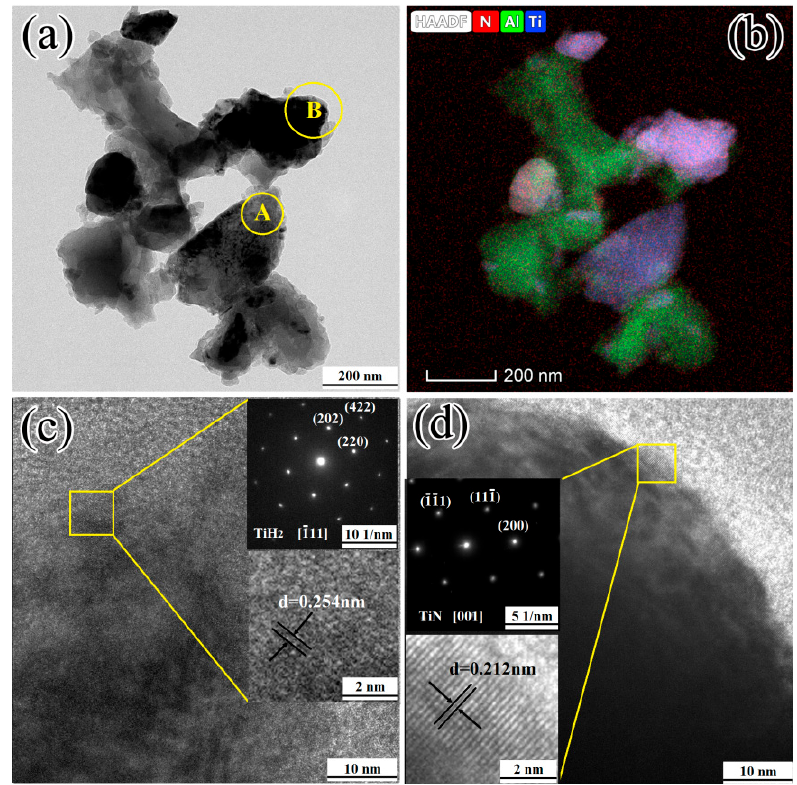
Figure 9. ( a ) TEM image; ( b ) elemental mapping of N, Al, and Ti; and ( c , d ) high-resolution transmission electron microscopy (HRTEM) image and selected area electron diffraction (SAED) pattern of 1TiH 2 /1.15Al/1TiN after one minute of sintering at 480 °C, respectively.